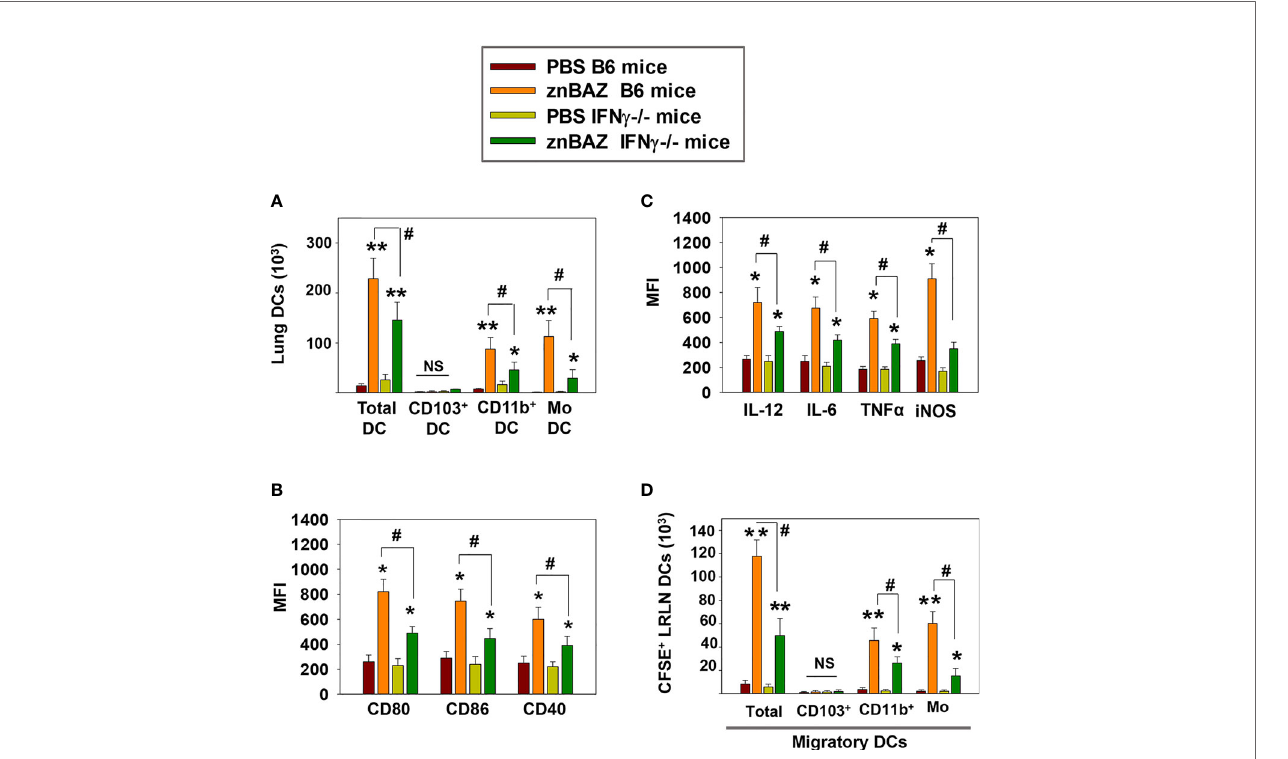
FIGURE 5 | IFN- g plays a key role in NK cell-mediated lung DC maturation and migration following znBAZ infection. Groups of B6 and IFN- g -/- mice were nasally infected with znBAZ (1×10 9 CFUs). (A – C) Flow cytometry analysis was performed on day 5 post-infection to quantify the numbers of lung DC subsets: (A) total lung MHC class II high CD11c + DCs, CD103 + DCs, CD11b + DCs and monocytic DCs (moDCs); and (B) MFI for their expression of CD80, CD86, CD40 and (C) MFI for IL- 12, IL-6, TNF- a , and iNOS. (D) To measure the number of migratory CFSE + lung DCs to the LRLNs, fl ow cytometry analysis was also performed on day 5 post- znBAZ infection of B6 and IFN- g -/- mice. The data depict the means ± SEM of 5 mice/group; *p < 0.01 and **p ≤ 0.001, compared with PBS-dosed mice, # p < 0.01 compared to znBAZ B6 mice; NS, not signi fi cant. Data are representative of two